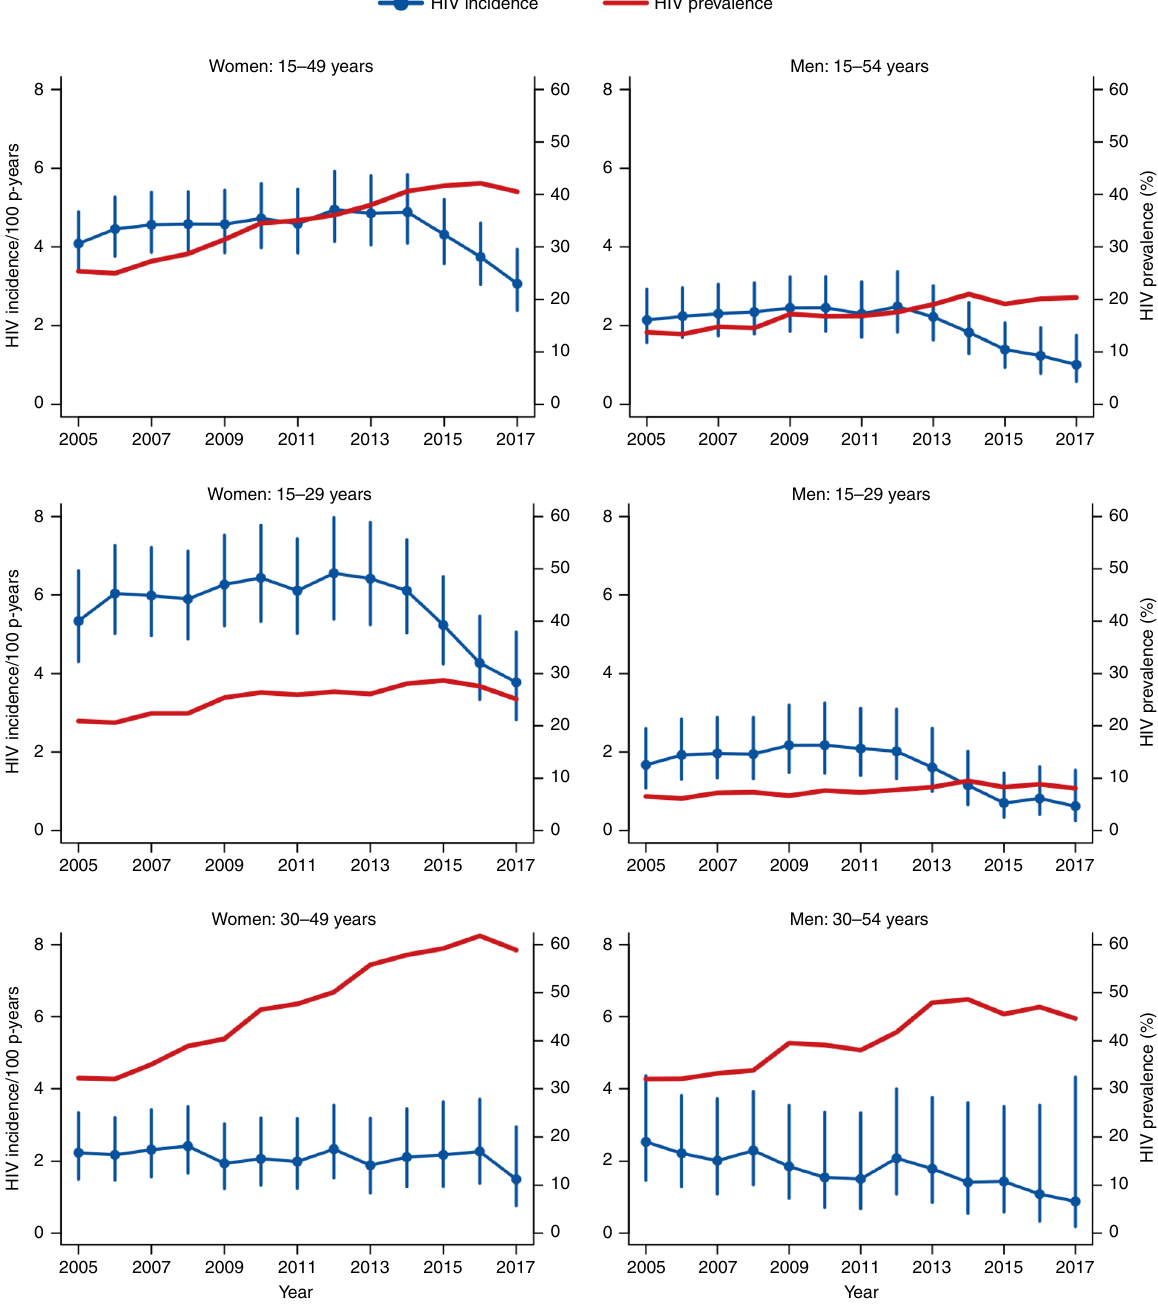
Fig. 2 HIV incidence rates (with 95% CIs) and HIV prevalence by sex and age. The fi gure shows that HIV incidence was highest among younger participants (15 – 29 years) and HIV prevalence was highest among older women (30 – 49 years). The largest declines in HIV incidence occurred among younger women, whereas HIV incidence was relatively fl at among older